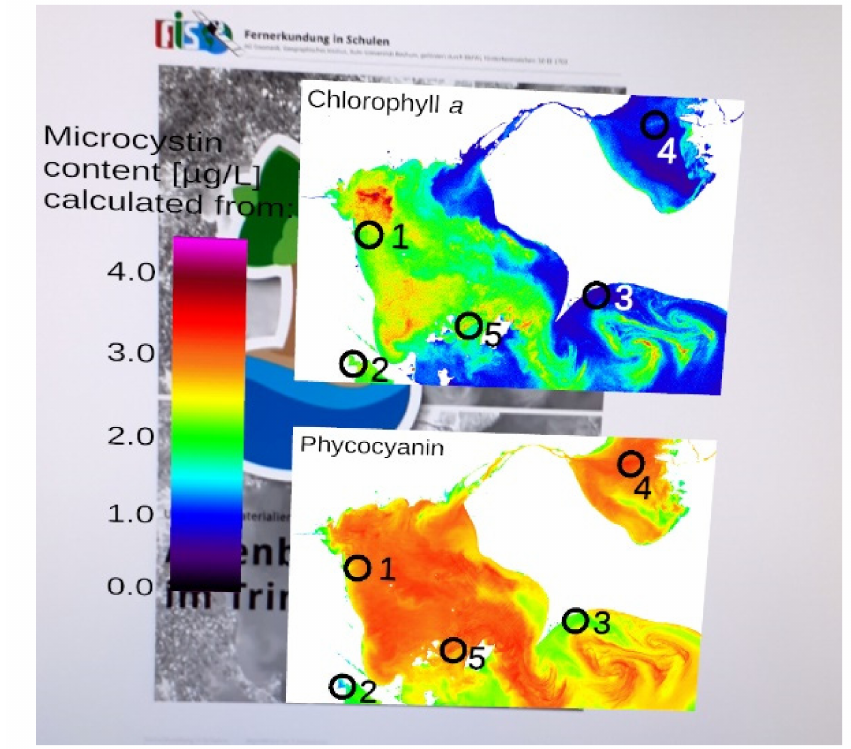
Figure 14. Microcystin distribution maps based on chlorophyll a and phycocyanin (English version of the app). Students can zoom in to see individual pixels by positioning their smartphone closer to the marker image below (Source: